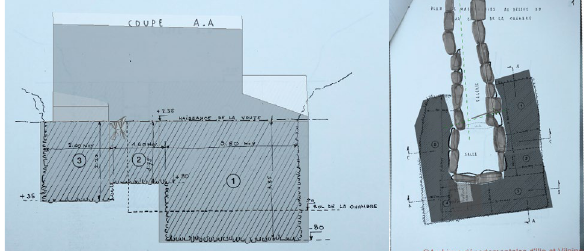
Figure 3. Section and plan view of the foundation masonry of the vault above the chamber: the sketch has been imported in the BIM model and was used to create the corresponding BIM elements.